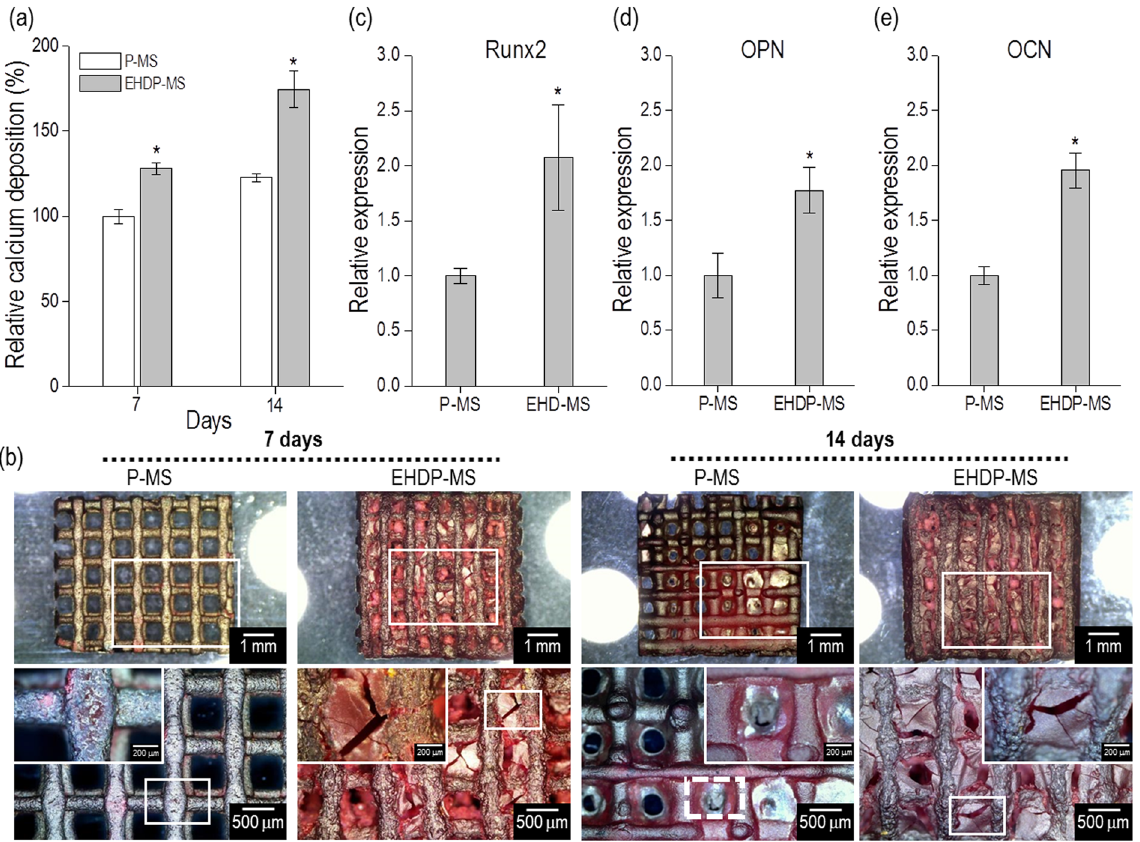
Figure 10. ( a ) Calcium deposition and ( b ) optical images of ARS staining of the P-MS and EHDP-MS following 7 d and 14 d of cell culture. Osteoblast differentiation marker genes, such as ( c ) Runx2, ( d ) OPN (osteopontin), and ( e ) OCN (osteocalcin) after cell-culture for 10